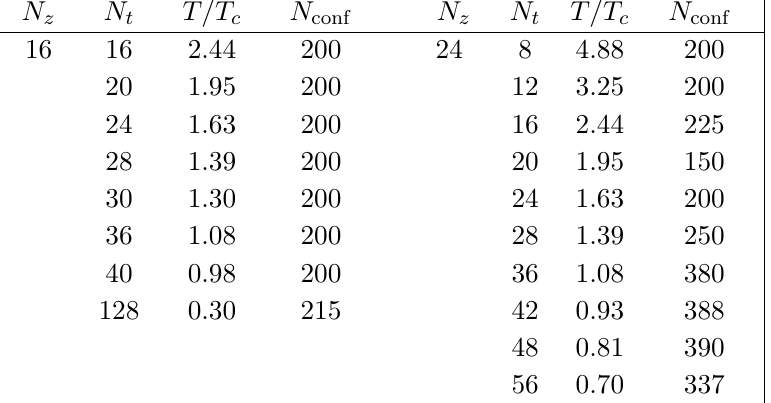
Table 4 . Details of the ensembles of the N t (cid:2) 16 3 and N t (cid:2) 16 2 (cid:2) 24 lattices. All calculations use (cid:24) 0 (cid:3) = 4 : 84, (cid:24) 0 (cid:3) = 4 : 72, m (cid:3) = (cid:0) 0 : 2148 and (cid:12) = 2 : 0. g 0 f